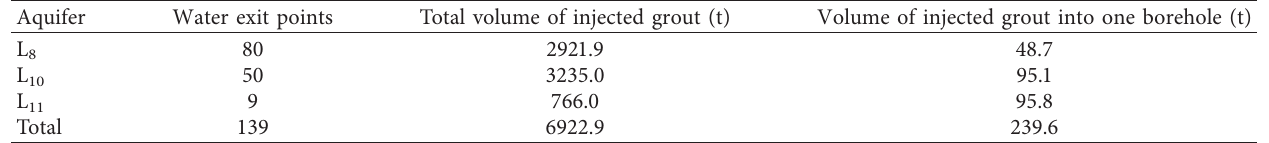
Table 6: Type III fracture.